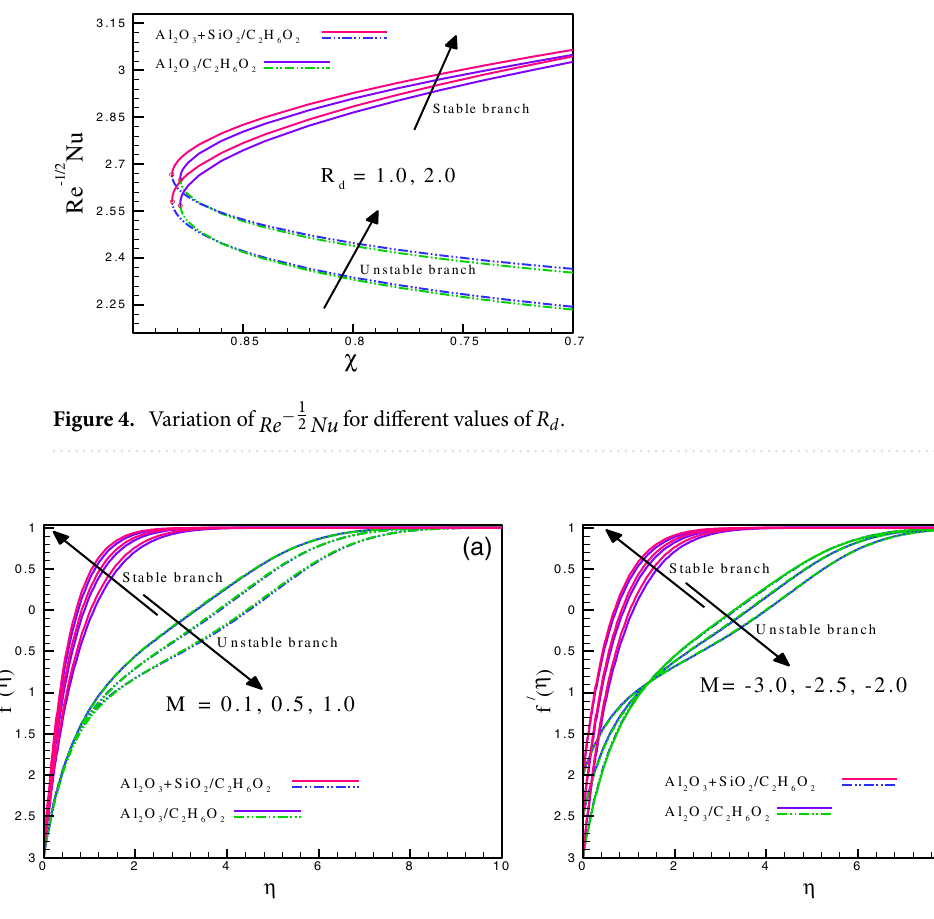
′ (η) for different values of M and χ